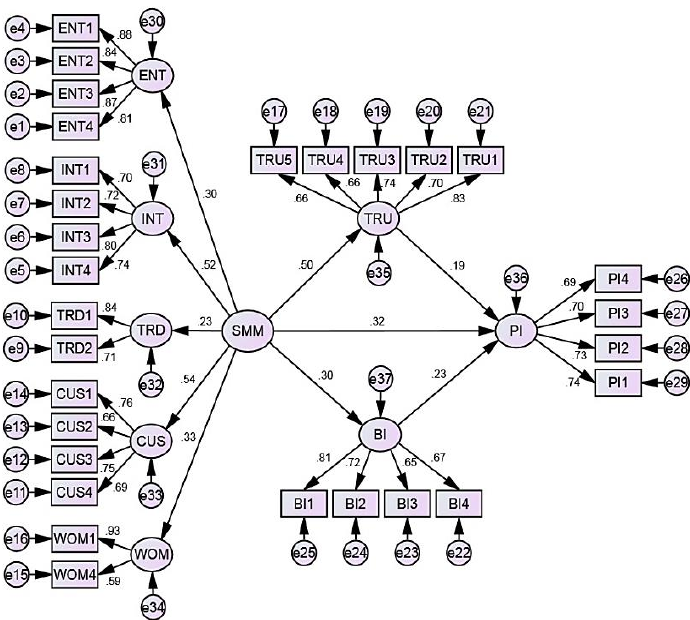
Figure 1. The result of SEM path analysis.